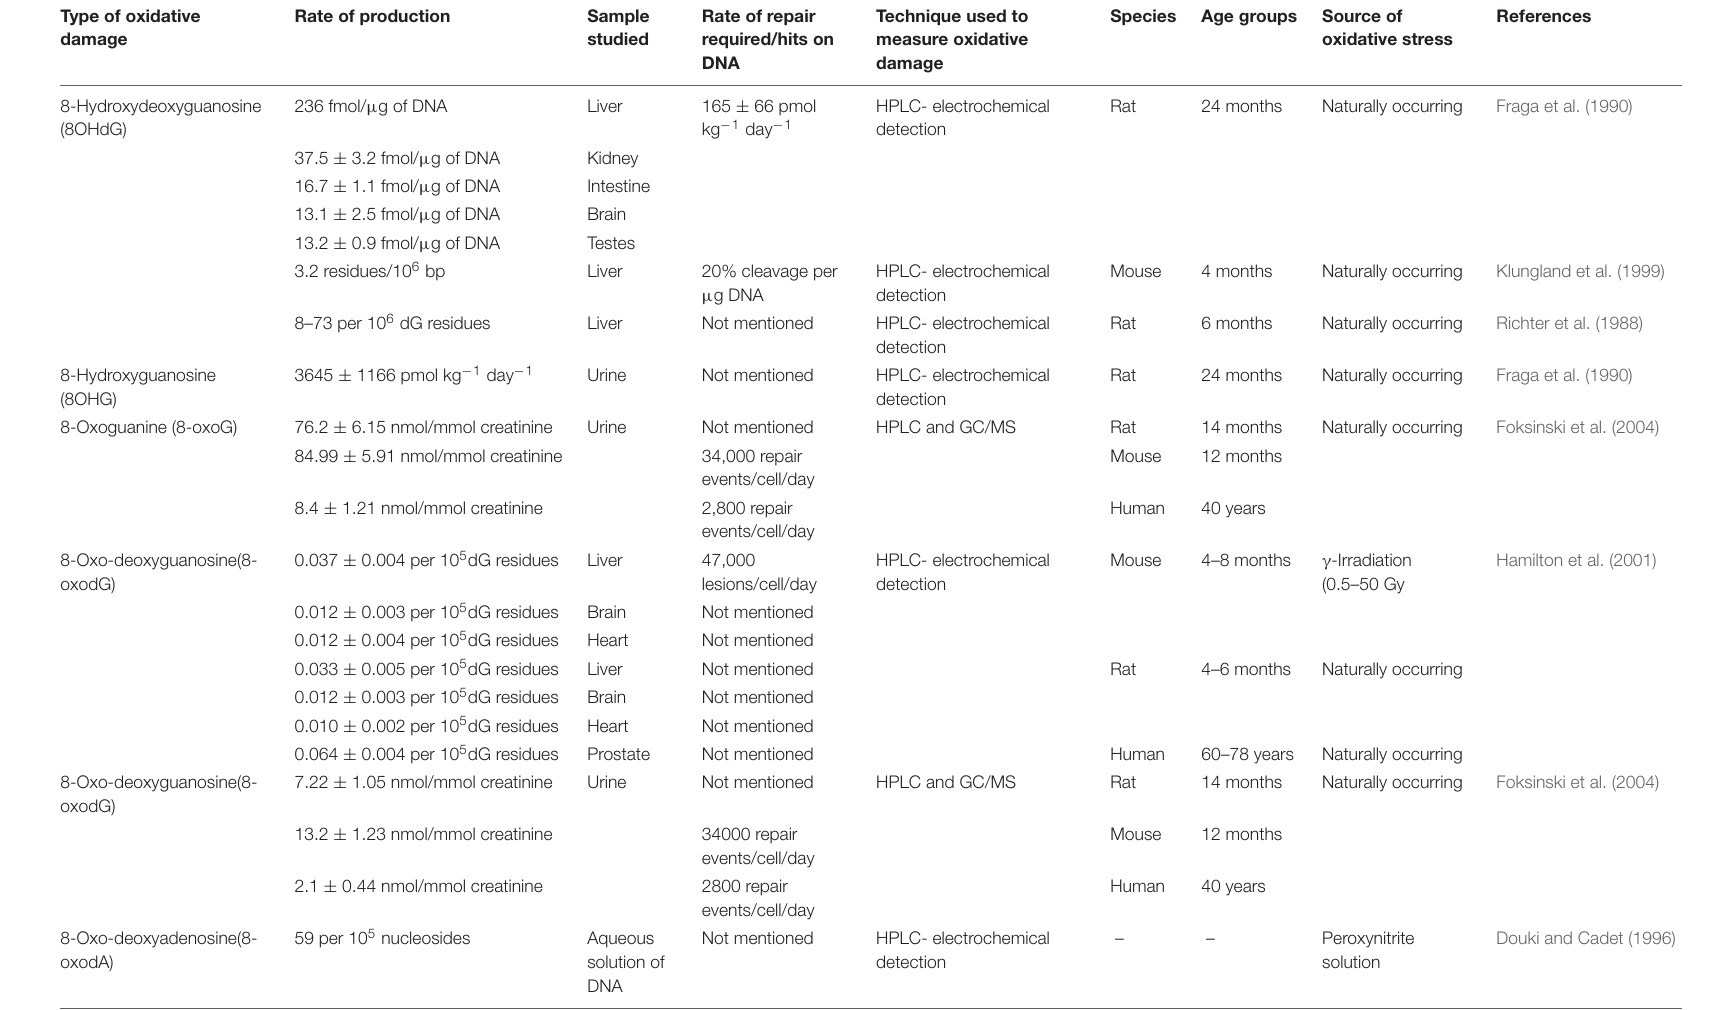
TABLE 2 | Relative amounts of oxidative damages on nucleic acids in aging. Type of oxidative